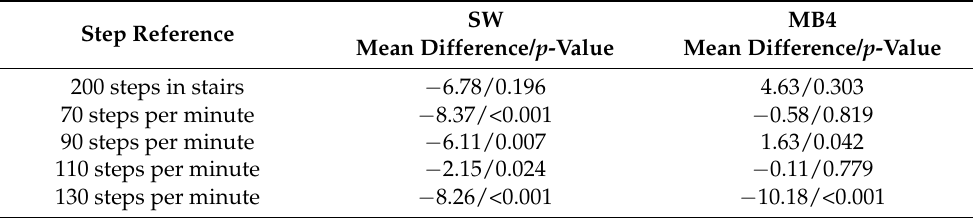
Table 2. Adjustment statistics of the number of steps by the T-test for a sample in relation to the reference steps.